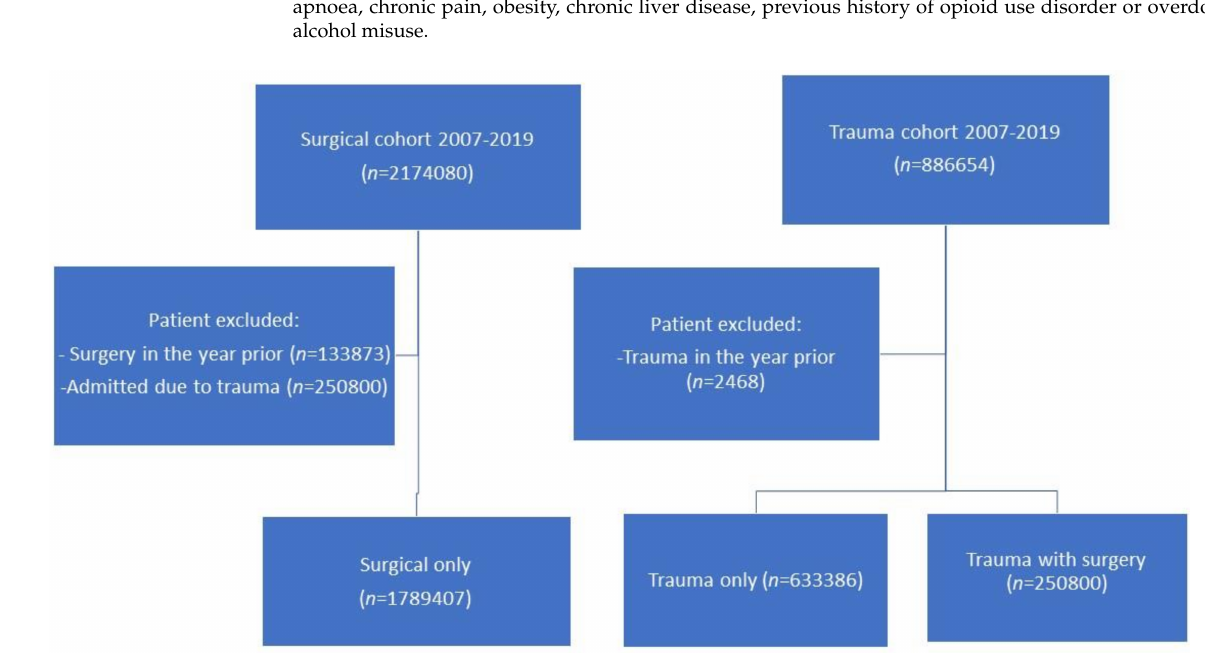
Figure 1. Patient